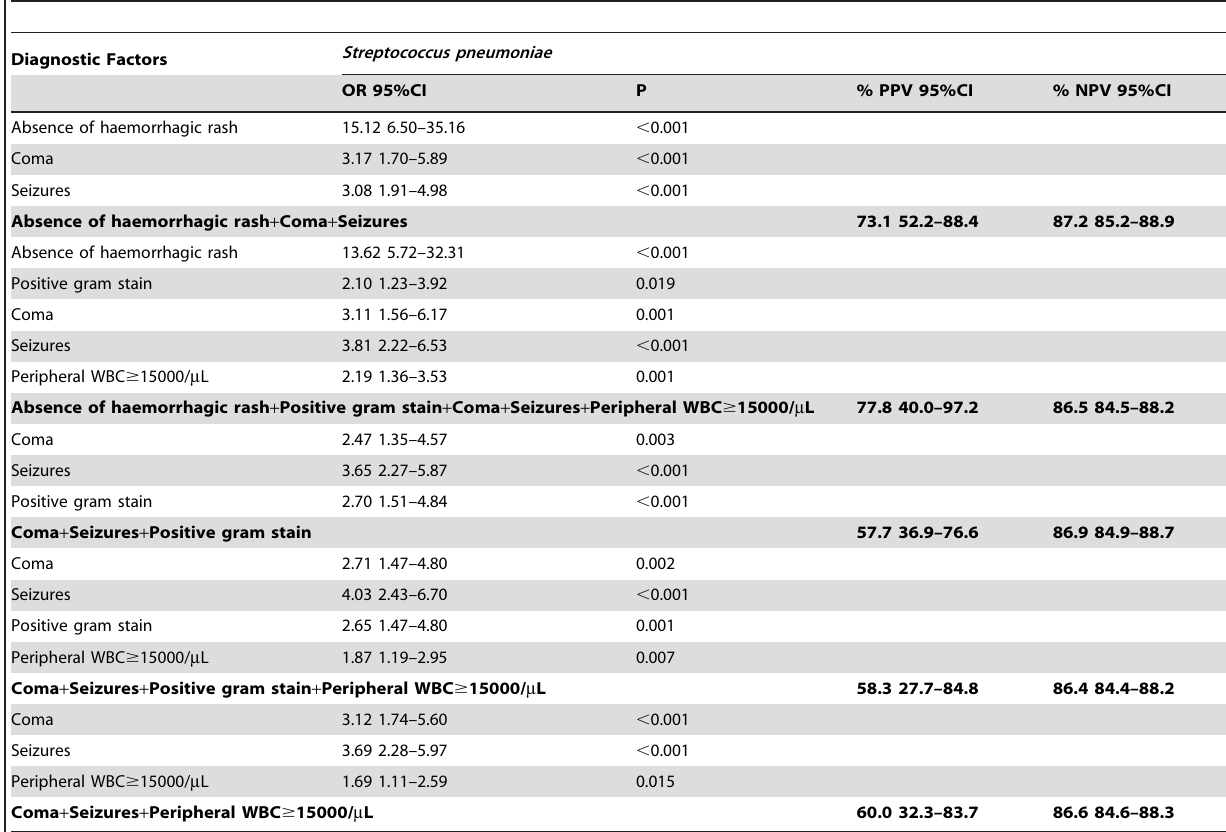
Table 8. Multivariate analysis of groups of diagnostic factors for the diagnosis of Streptococcus pneumoniae .